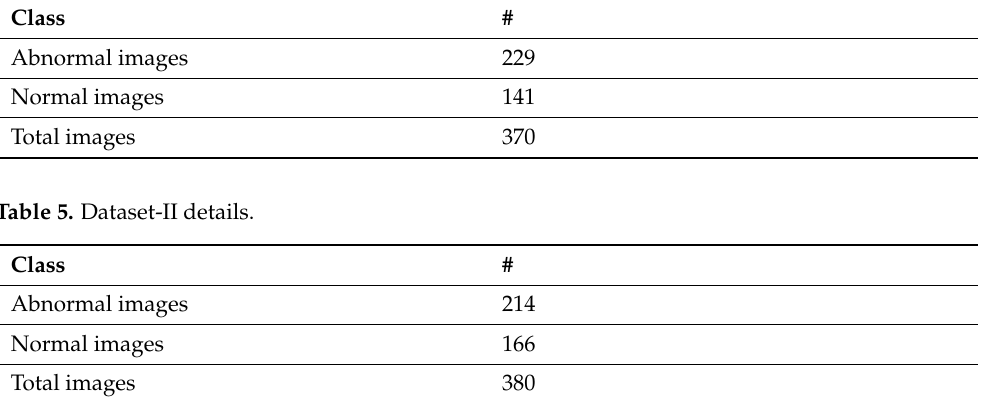
Table 4. Dataset-I details.